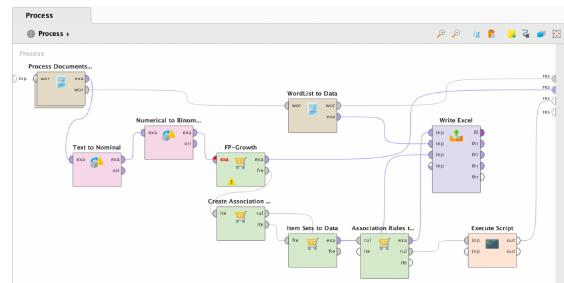
Figure 4 . Association Rules Mining Process on RapidMiner